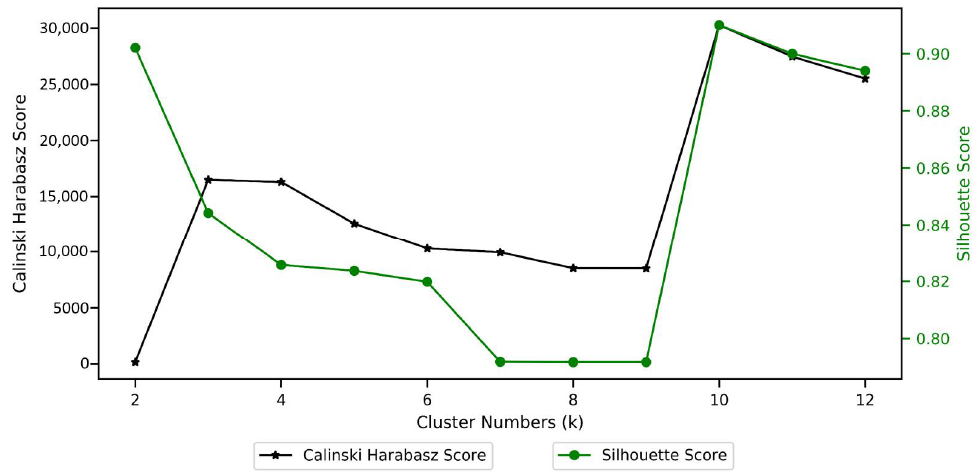
Figure 5. k -Selection using Calinski–Harabasz and Silhouette